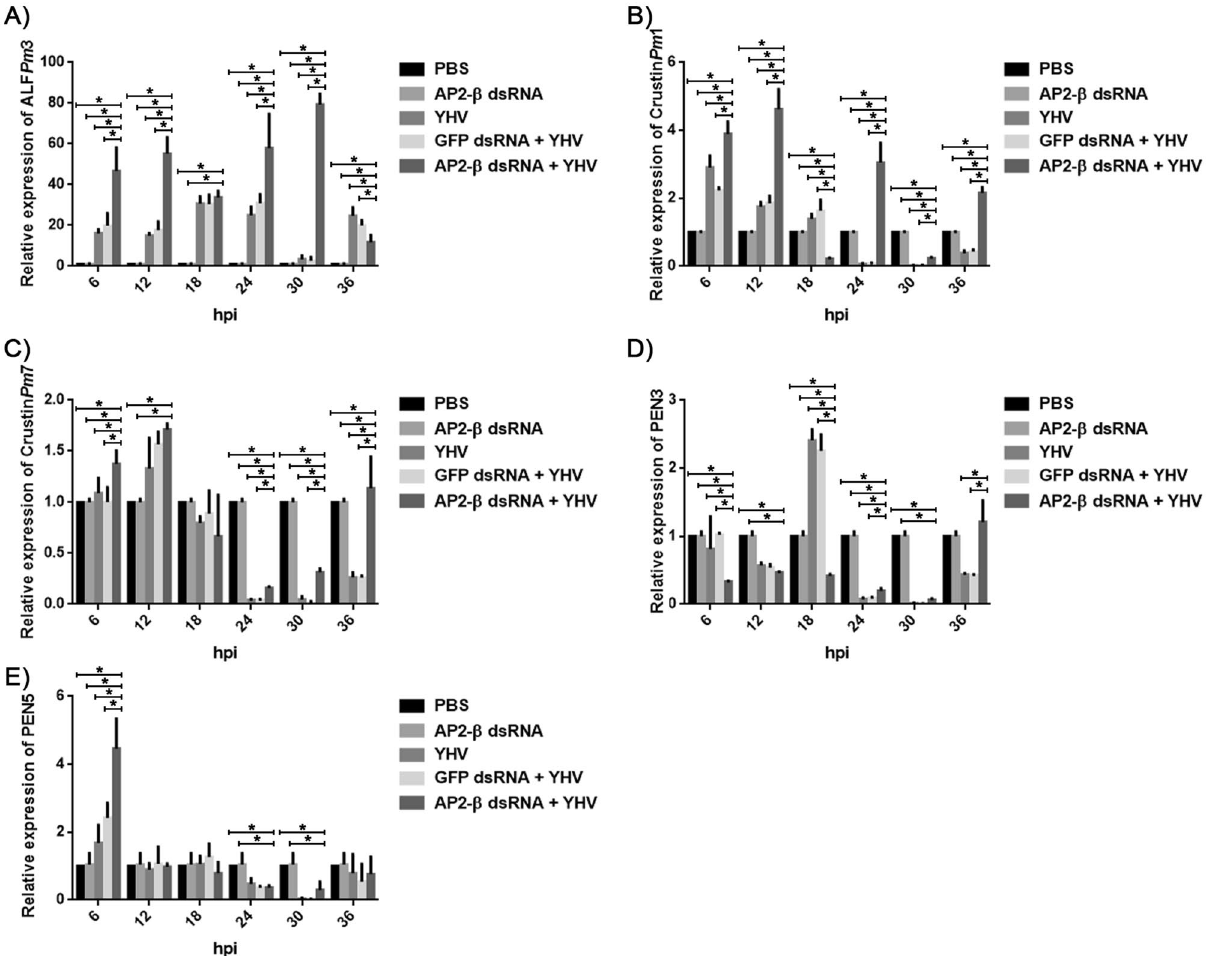
Figure 5. Determination of the mRNA transcription levels of antimicrobial peptides under influence of Pm AP2-β knockdown during YHV infection. ALF Pm 3 ( A ), Crustin Pm 1 (B ), Crustin Pm 7 ( C ), PEN3 ( D ) and PEN5 ( E ) transcripts of Pm AP2-β-silenced shrimp challenged by YHV at 6, 12, 18, 24, 30, 36 h were quantified by qRT-PCR and compared with those in unchallenged Pm AP2-β-silenced, YHV-challenged, and YHV- challenged + GFP knockdown